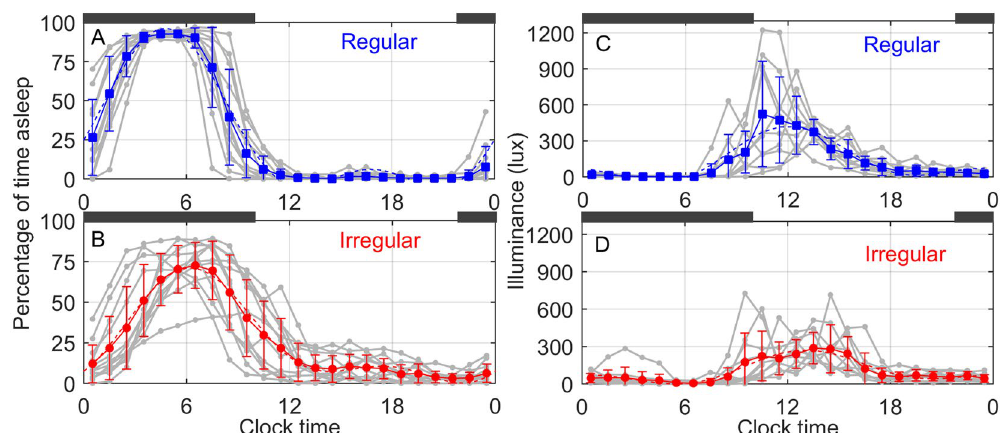
Figure 2. Sleep/wake and light/dark cycles differ between Regular and Irregular groups. Gray lines show individual data ( n = 12 for each sleep/wake panel and n = 11 for each light/dark panel). Colored lines show group mean and standard deviation in one-hour bins, with data for each individual averaged across the whole study interval (i.e., multiple days). Dark gray bars indicate clock night (22:00 to 10:00). Left panels: Sleep/wake rhythm (percentage of time asleep) for ( A ) Regular and ( B ) Irregular sleepers. Right panels: Normalized light levels for ( C ) Regular and ( D ) Irregular